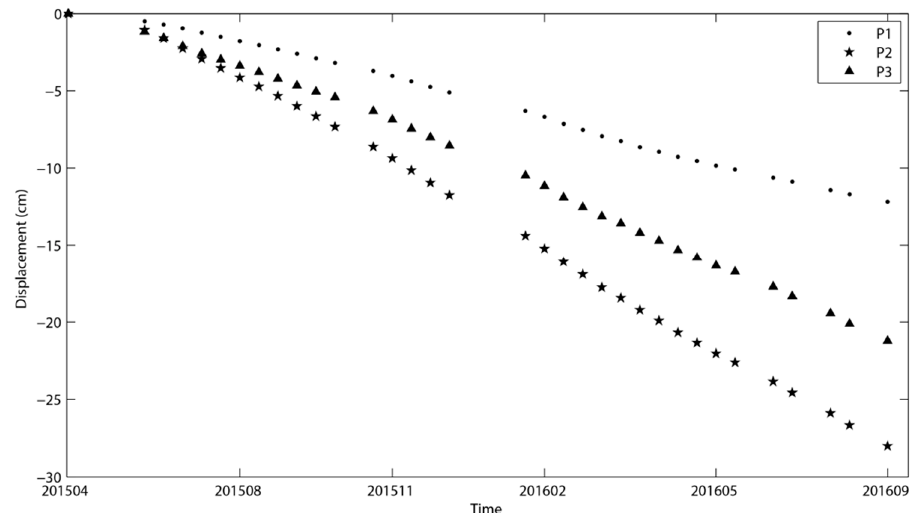
Figure 7. Time-series results of points P1, P2 and P3 (see Figure 4) between 2015/04/13 and 2016/09/10, where the horizontal axis represents time and the vertical axis indicates the deformation in the LOS direction.